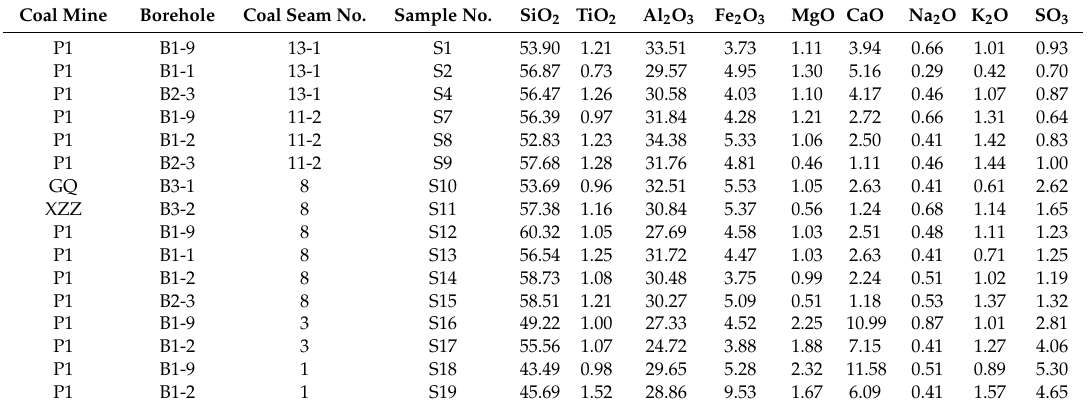
Table 2. Concentration of major element oxides (%) of the coal samples from the Huainan coalfield. Coal Mine Borehole Coal Seam No. Sample